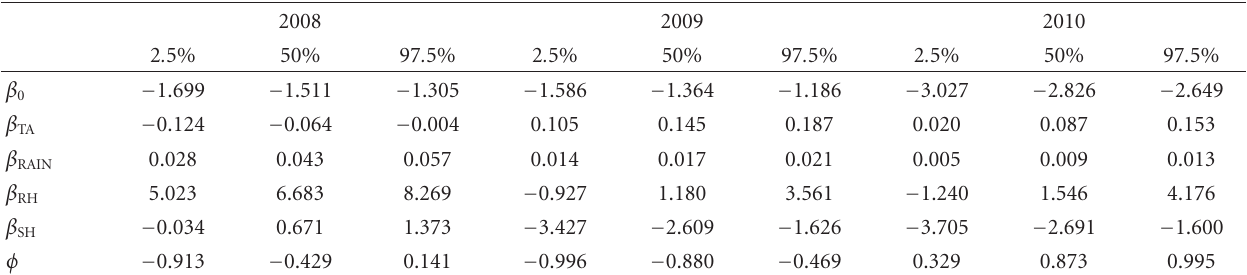
Table 2: Estimated posterior medians and 95% credibility interval for the autoregressive model.